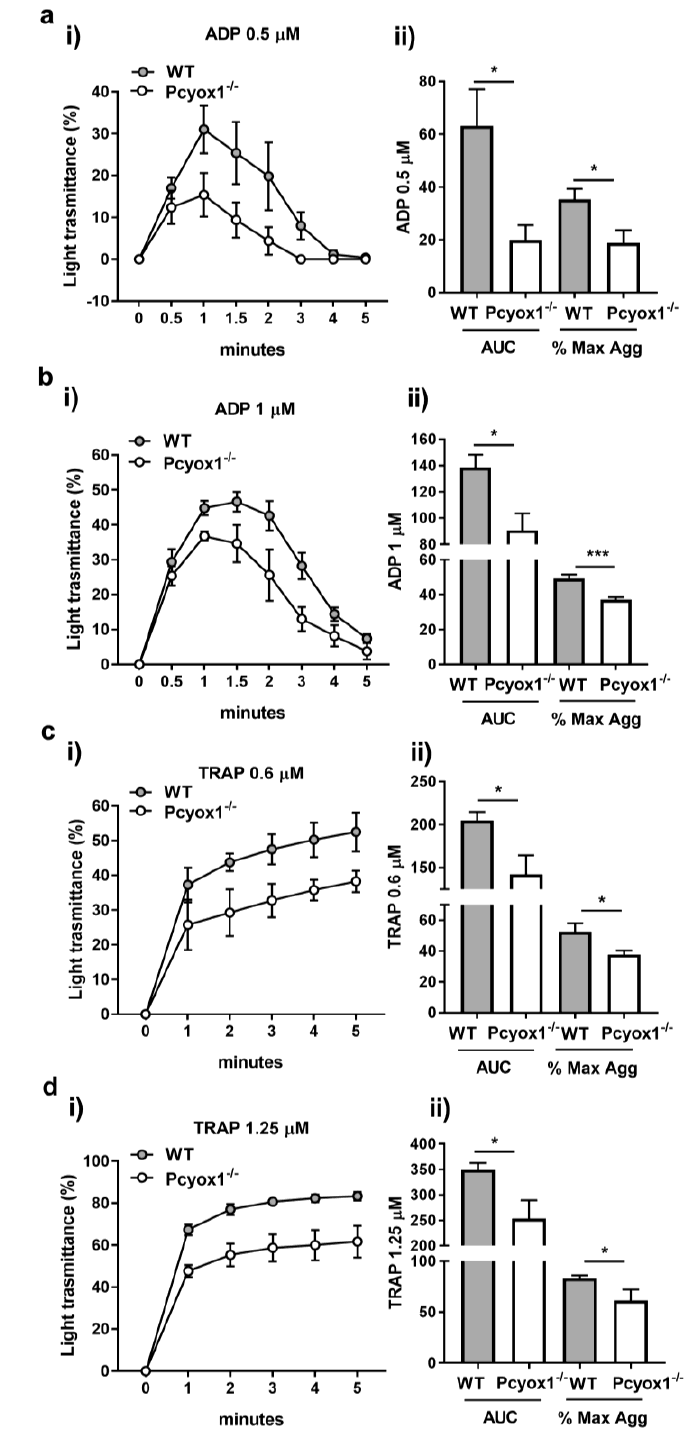
Figure 4. Platelet-rich plasma aggregation in WT and Pcyox1 −/− deficient mice. Platelet aggregation was performed in PRP in response to different concentrations of ( a , b ) ADP (0.5 – 1 µM) and ( c , d ) TRAP (0.6 – 1.25 µM). Data are shown as (i) kinetic of light transmission, and (ii) area under the curve (AUC) and % of maximum aggregation (% Max Agg) during the 5 min of recording. (Grey bar: WT mice; white bar: Pcyox1 −/− mice). n = 5 mice/group. Data are shown as mean ± SEM. * p < 0.05, and *** p < 0.005 at Mann-Whitney U-test.